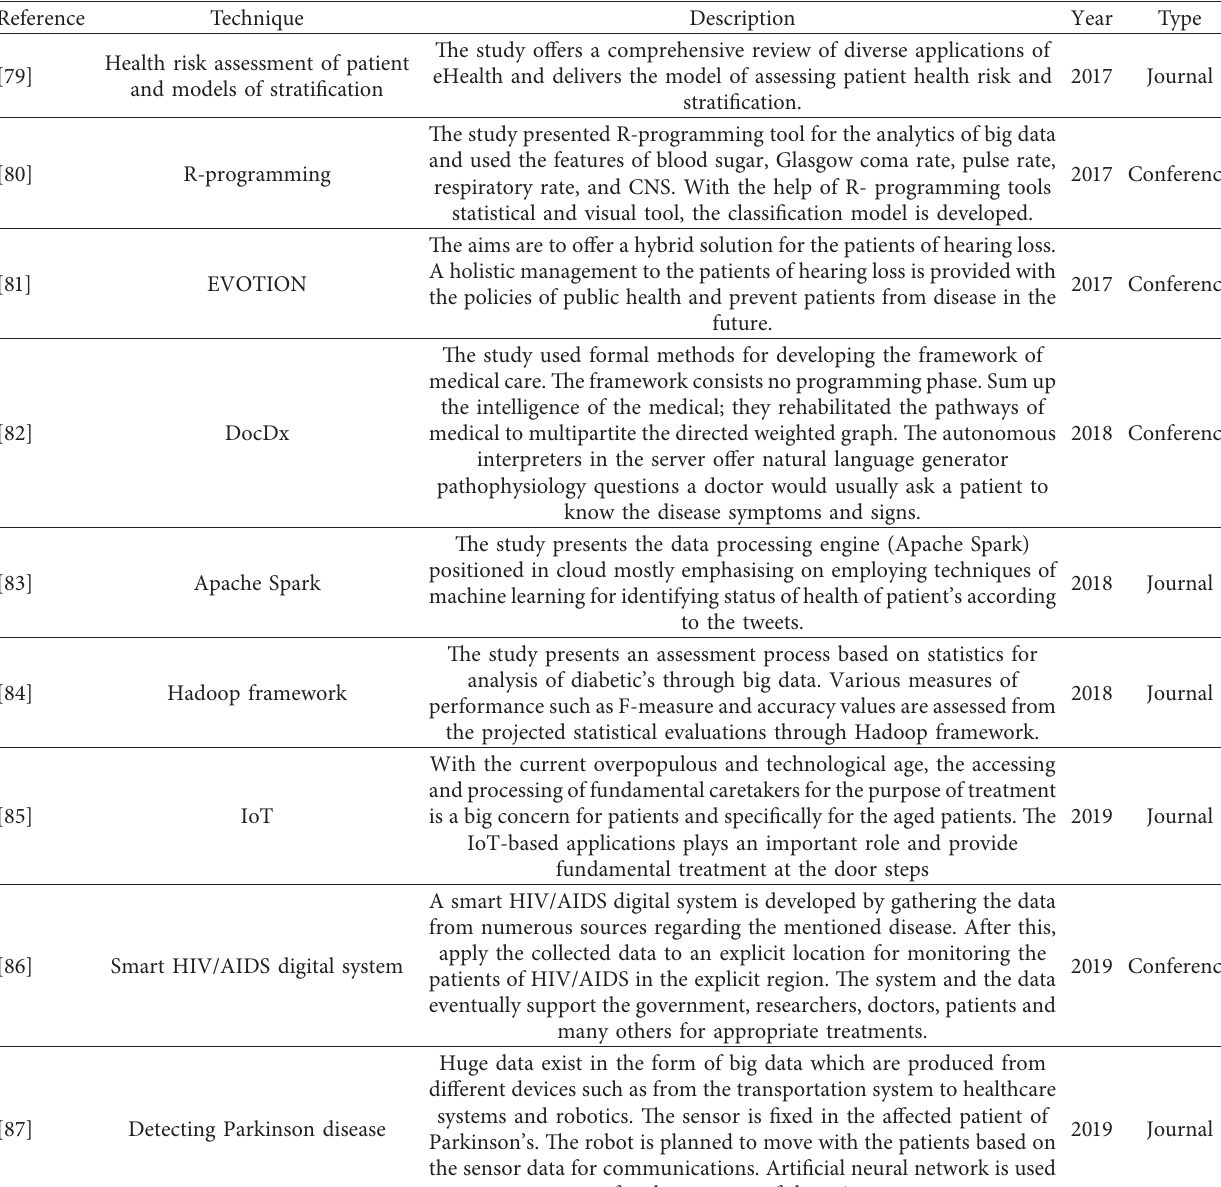
Table 2: Applications of approaches used in the healthcare.